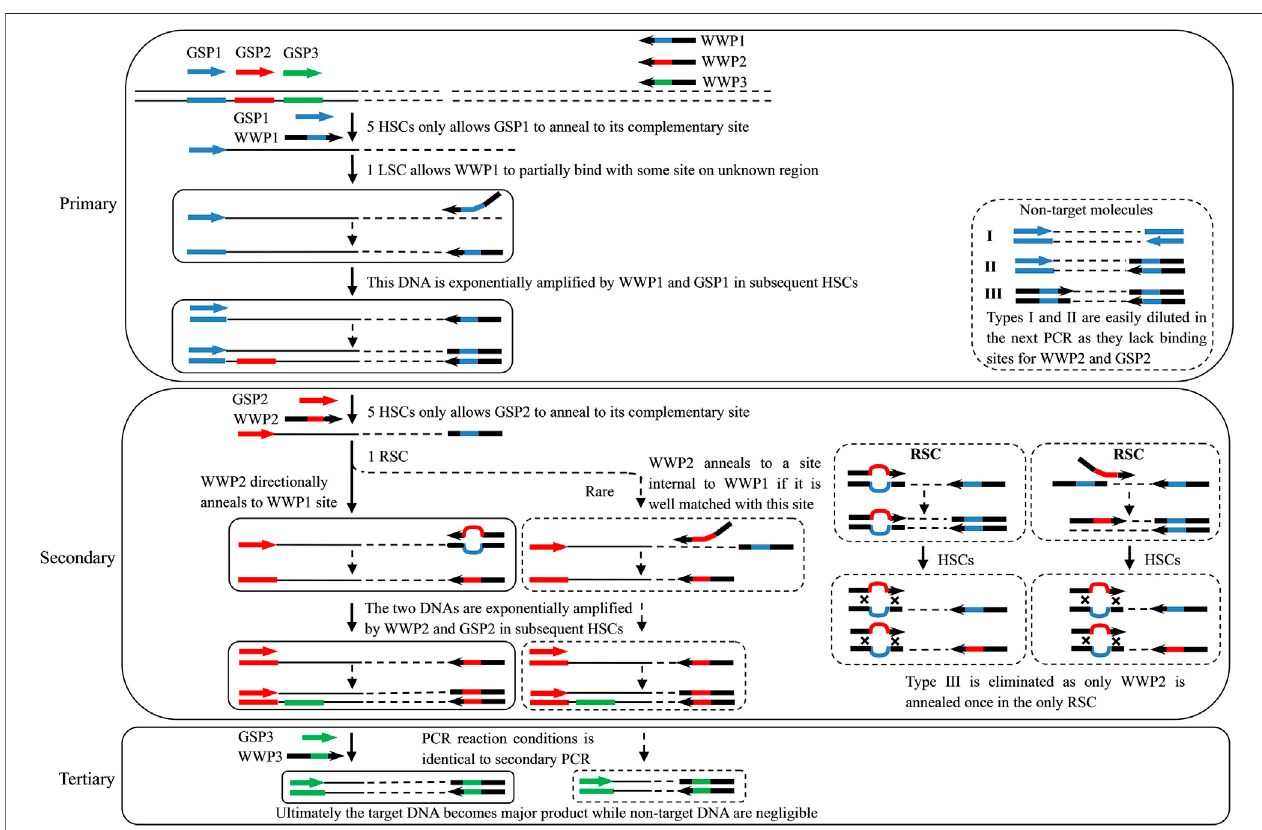
FIGURE 1 | Overview of the wristwatch PCR. GSP1, GSP2, and GSP3: gene-speci fi c primers for primary, secondary, and tertiary PCRs, respectively; WWP1, WWP2, and WWP3: wristwatch primers for primary, secondary, and tertiary PCRs, respectively; thin solid line: known sequence; thin dotted line: unknown sequence; colorfulthickline:primer complement; HSC,high-stringencycycle;LSC, low-stringency cycle;andRSC, reduced-stringency cycle.OnlytheWWPpermutationWWP1- WWP2-WWP3 is presented here to illustrate the wristwatch PCR. The sequence of any WWP is random. However, WWPs can anneal to each other ’ s complements in the RSC attributed to the partial overlap (as shown in Table 1 ), thus generating a wristwatch-like structure.